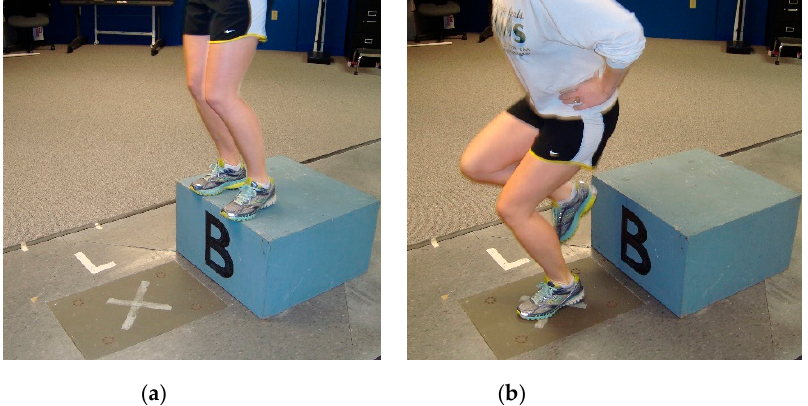
Figure 1. Participant body positioning for the drop-land: ( a ) forward lean off of platform; ( b ) single limb landing.